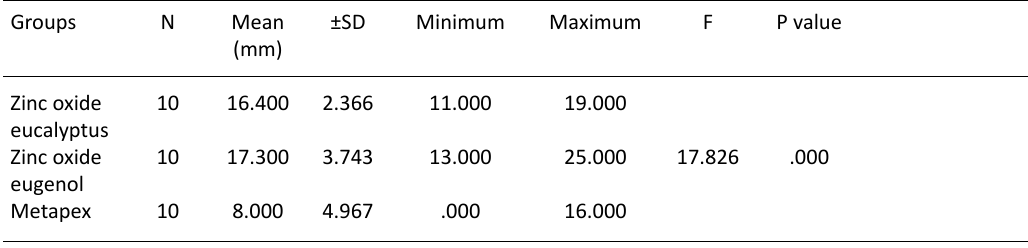
Table 3. Mean value of inhibition zones of obturation materials against Streptococcus spp. in millimeter Groups